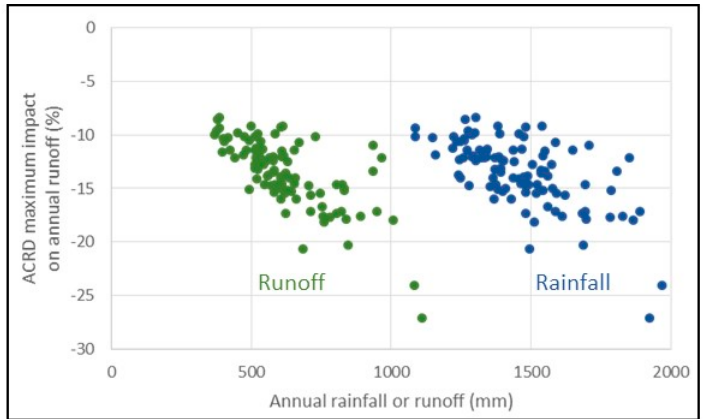
Figure 12. Maximum ACRD impact on annual runoff at Node 14 versus annual rainfall or runoff in the year of maximum impact (from the 100 stochastic simulations).